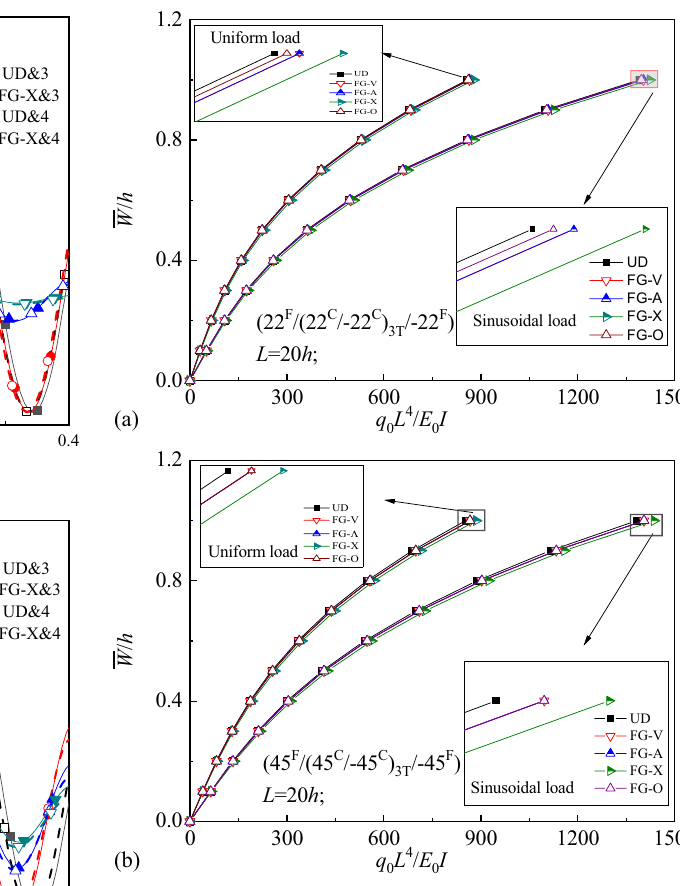
Figure 15: Load versus de fl ection of hybrid laminated plate com - posed of di ff erent CNT distribution